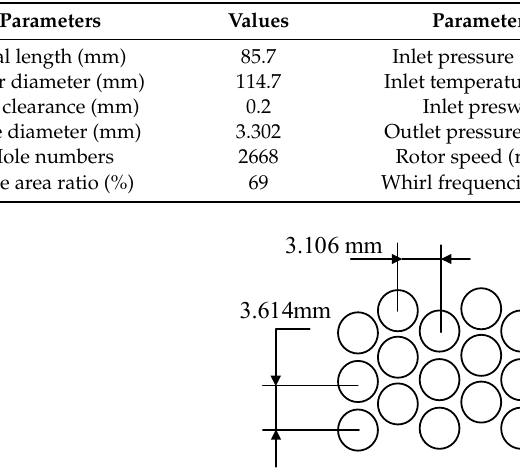
Figure 2. Schematic diagram of pressure extraction for minimum and maximum sealing clearance. Table 1. Basic parameters of constant clearance damper seals in Reference [15].